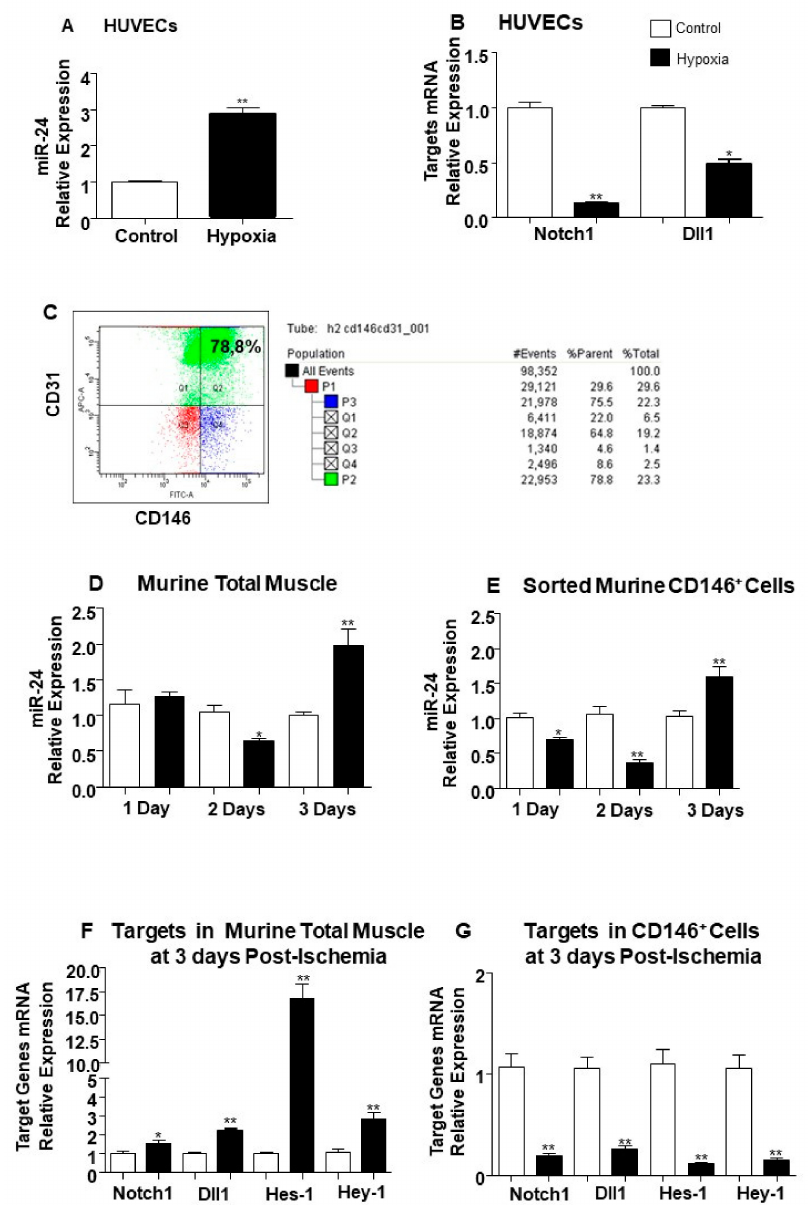
Figure 4. Modulation of miR-24-3p, Notch-1, and Dll1 mRNA expression by in vitro hypoxia and limb ischemia. ( A ) Bar graph shows miR-24-3p expression changes induced in endothelial cells (ECs) by culture for 48 h in hypoxia (1% O 2 , black column) versus standard cell culture conditions (21% O 2 , white column). ( B ) Bar graph shows Notch1 mRNA and Dll1 mRNA modulation by hypoxia in the same cells preparations used for the analyses shown in Panel A. ( C ) FACS analysis plot shows murine sorted CD146 + cells stained with FITC-conjugated CD146, APC-conjugated CD31 antibodies. The